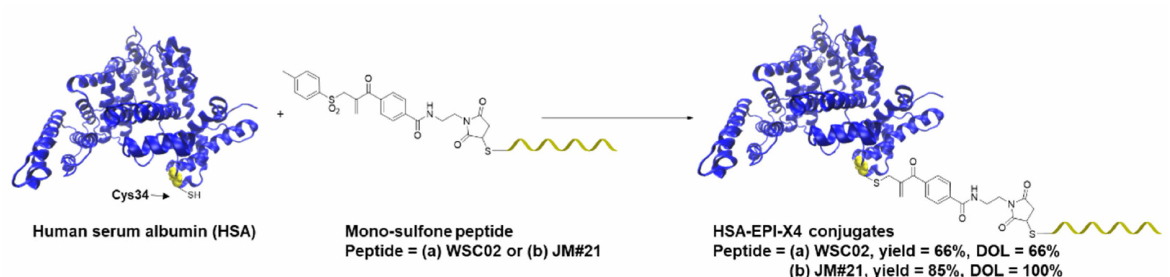
Figure A4. Preparation of HSA-peptide conjugates by conjugation of mono-sulfone peptide to unpaired cysteine in